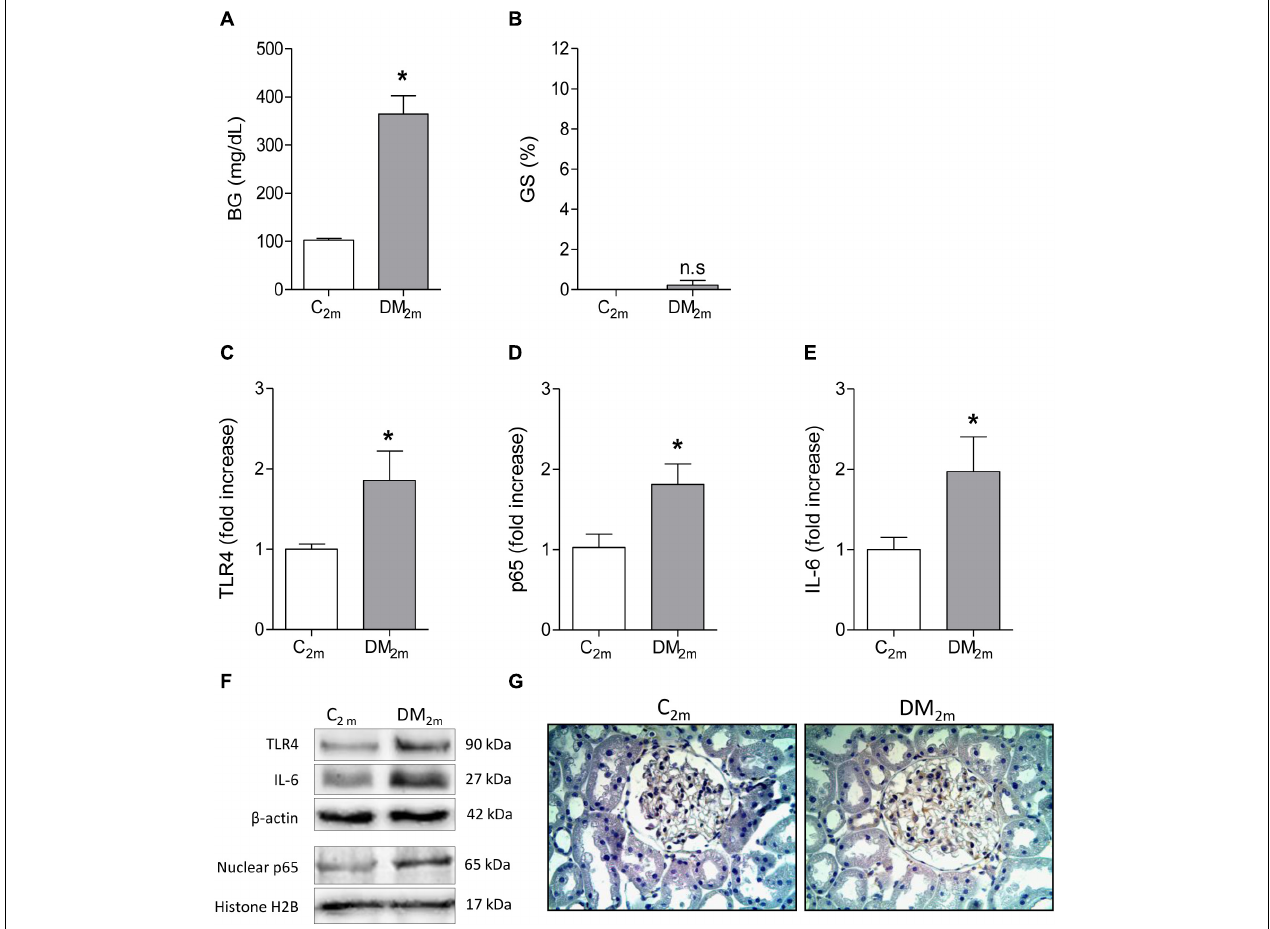
FIGURE 4 | Blood glucose concentration (BG, mg/dL) and frequency of glomeruli with sclerotic lesions (GS,%), observed in Control (C 2m group, n = 5) and DM (DM 2m group, n = 7) rats 2 months after STZ injection, are shown in panels (A,B), respectively. The renal cortical contents of Toll-like receptor 4 (TLR4) (C) , nuclear fraction of phosphorylated p65 (D) and interleukin-6 (IL-6) (E) were quantified using Western blot analysis (F) . In panel (G), representative microphotographs show the presence of p65-positive immunostaining (brown) in glomeruli ( × 400). Results expressed as means ± SE. * p < 0.05 vs. C 2m